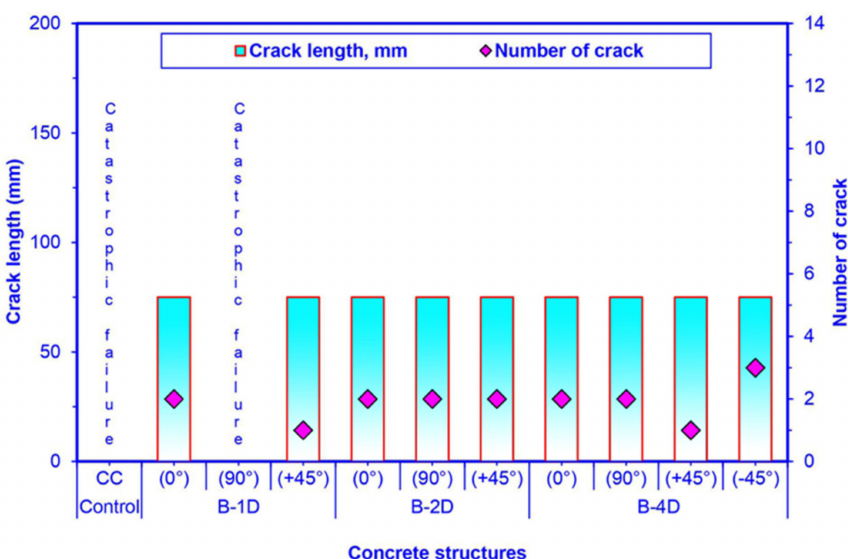
Figure 17. Number of cracks and crack length in fractured multiaxis 3D basalt fiber concretes after off-axis four-point flexure test.